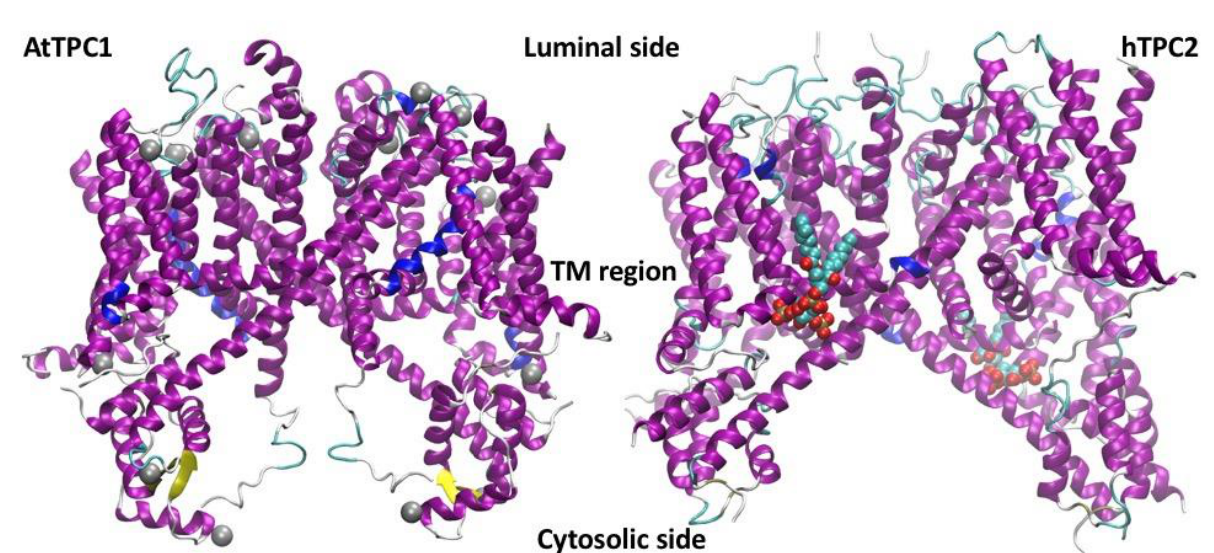
Figure 2. Molecular structures of AtTPC1 and hTPC2. (LEFT) Side view of the high-resolution tridimensional structure of AtTPC1 (X-ray at 2.87 Å, pdbid: 5dqq) with the bound calcium ions as gray spheres. (RIGHT) Side view of the high- resolution tridimensional structure of hTPC2 (cryo-EM at 3.7 Å, pdbid:6dq0) with the PI(3,5)P 2 effector bound to the two homodimers represented as van der Waals spheres. The two proteins differ for the presence of the EF hands in AtTPC1 on the cytosolic side (bottom in the figure), able to bound calcium ions.